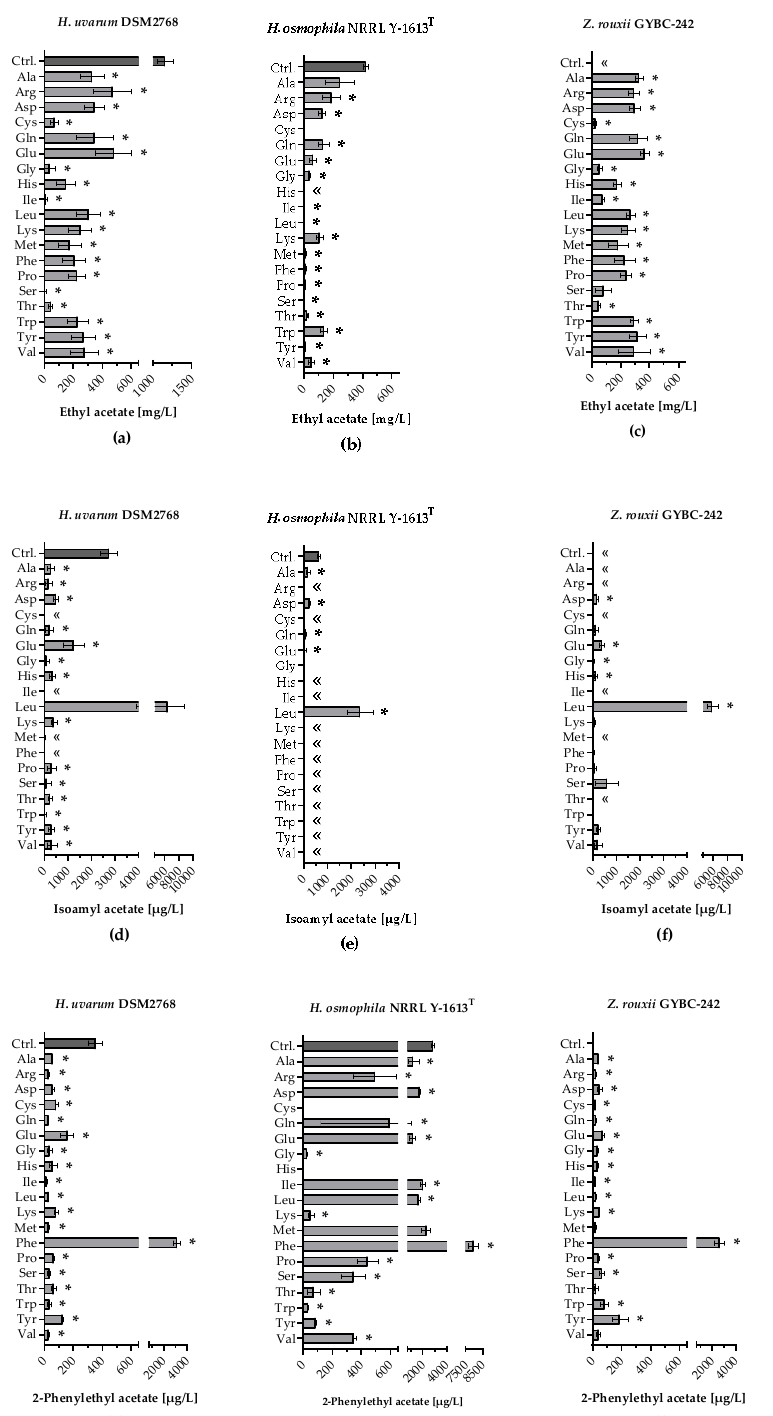
Figure 5. Production of acetate esters during fermentation with individually supplemented amino acids. Ethyl acetate production [mg/L] in fermentations using ( a ) H. uvarum DSM2768, ( b ) H. osmophila NRRL Y-1613T and ( c ) Z. rouxii GYBC-242. Isoamyl acetate production [ µ g/L] in fermentations using ( d ) H. uvarum DSM2768, ( e ) H. osmophila NRRL Y-1613T and ( f ) Z. rouxii GYBC-242. 2-Phenylethyl acetate production [ µ g/L] in fermentations using ( g ) H. uvarum DSM2768, ( h ) H. osmophila NRRL Y-1613T and ( i ) Z. rouxii GYBC-242. Fermentations using the respective yeast with SM-mix served as control (Ctrl.). Acetate esters were measured via HS-SPME-GC-MS analysis. Data are the mean of three independent experiments ± SEM, two-tailed unpaired t test with Welch’s correction, * p < 0.05 as compared to the control. Error bars indicate the standard deviation; «: not